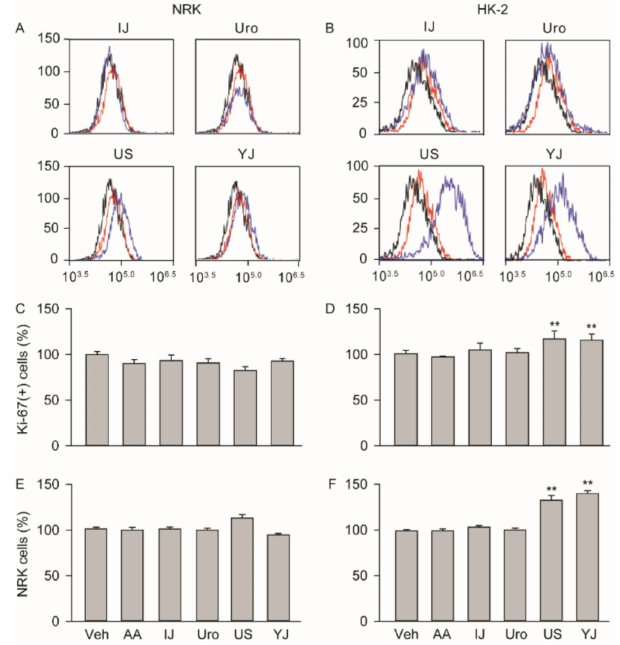
Figure 5. E ff ects on cell proliferation. Cells were treated with AA, IJ, Uro, US, or YJ under serum-free conditions for 3 days, and Ki-67-positive proliferative cells were measured in the NRK ( A ) and HK-2 ( B ) using flow cytometry. Blue and red lines indicate the polyherb treatment groups and vehicle control (Veh), respectively. Black indicates the experimental control omitting the primary antibody. Results are expressed as a percentage of the Veh group ( C , D ). In addition, the cell growth was assessed and expressed as a percentage of the Veh group ( E , F ). Values are means ± SD from five independent experiments. **: p < 0.01 versus the Veh